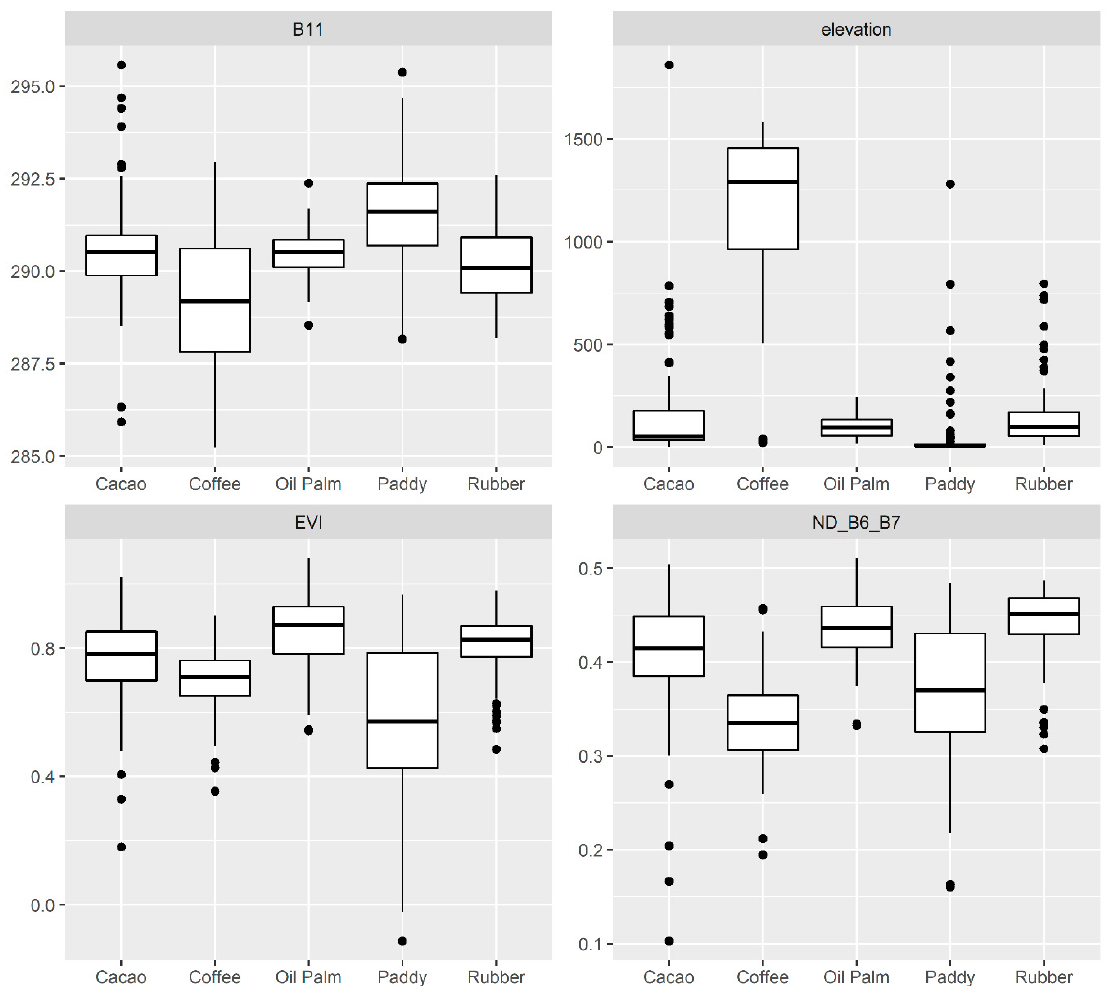
Figure 5. Characteristics of the 4th most important predictors in the RF classifier. B11 represents land surface temperature in Kelvin unit, elevation shows in meter above sea level, EVI and covariate between B6 and B7 (ND_B6_B7) were units less. The boxplot shows the characteristics of features within commodities—horizontal line represents the average of the value of commodity and the black dotted visualized the outlier of the features within commodity.